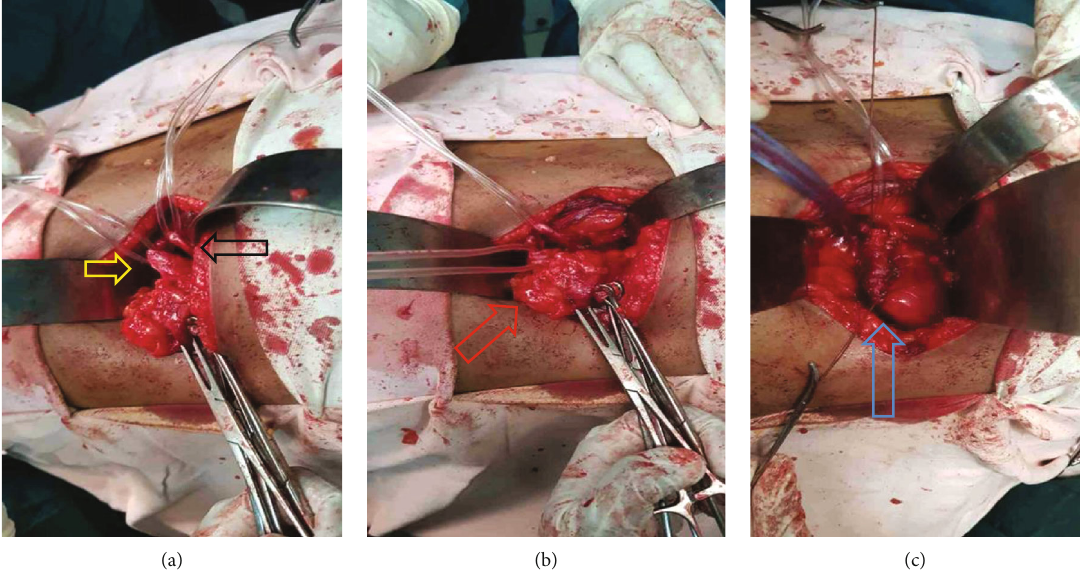
Figure 3: Intraoperative imaging. (a) Dilated proximal ureter draining lower moiety (yellow arrow), another ureter draining upper moiety (black arrow). (b) Hydronephrotic segment (red arrow). (c) Repair of the upper segment after lower pole resection (blue